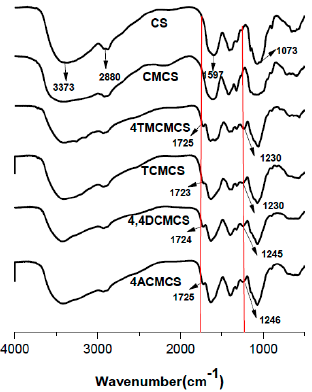
Figure 2. FT-IR spectra of CS, N, O-CMCS, and Carboxymethyl chitosan containing thiourea salts.